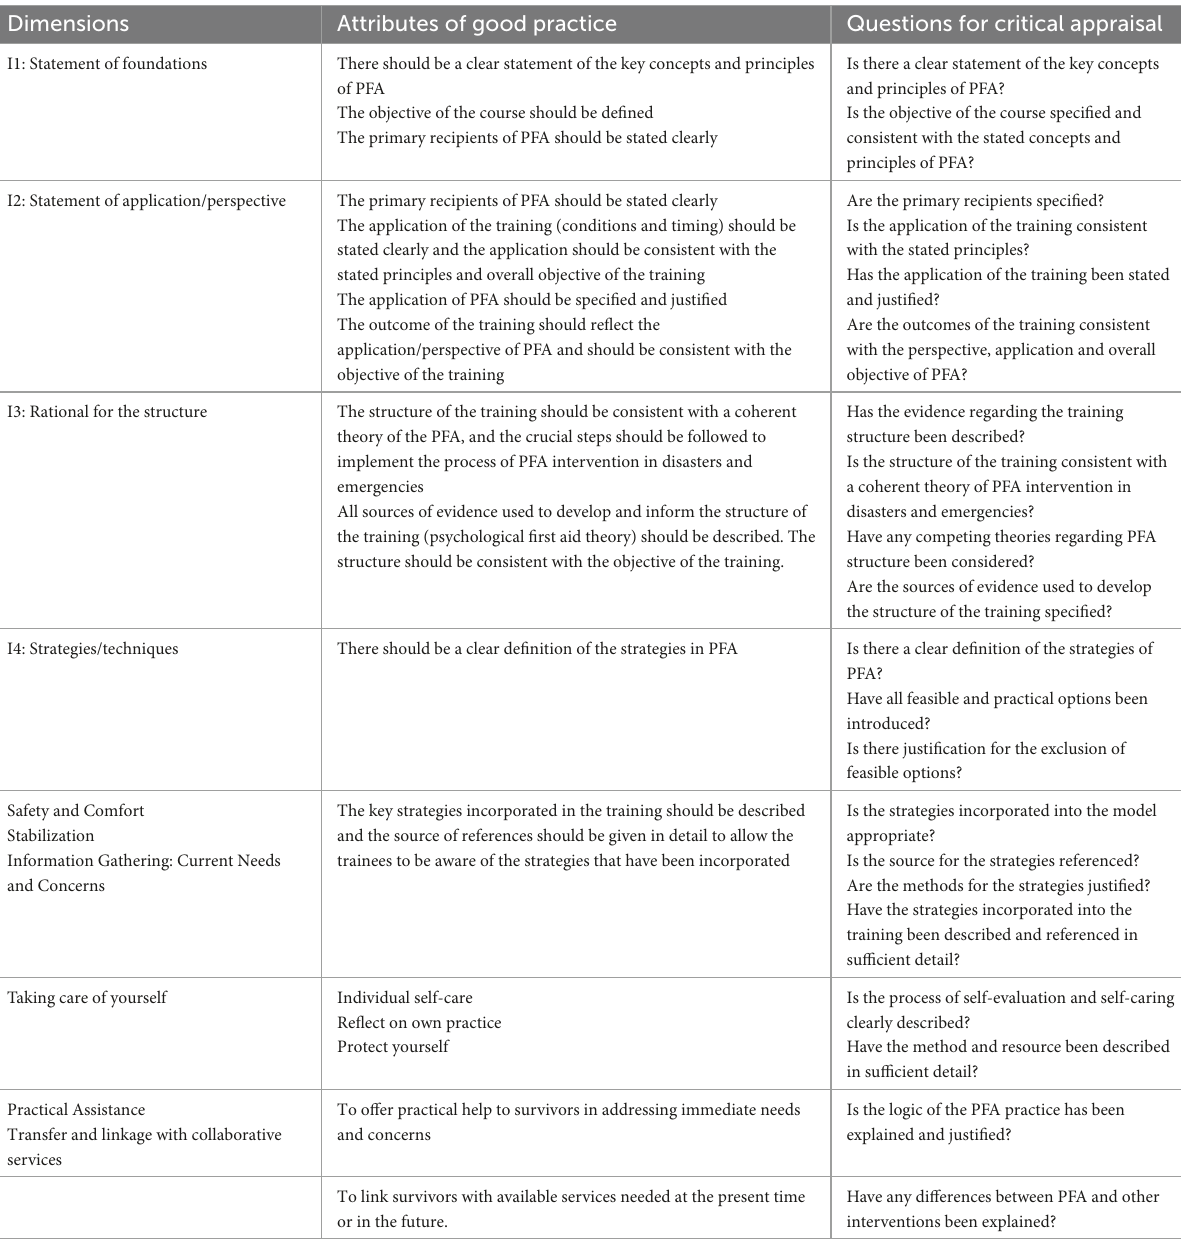
TABLE 1 Fidelity checklist (Intervention